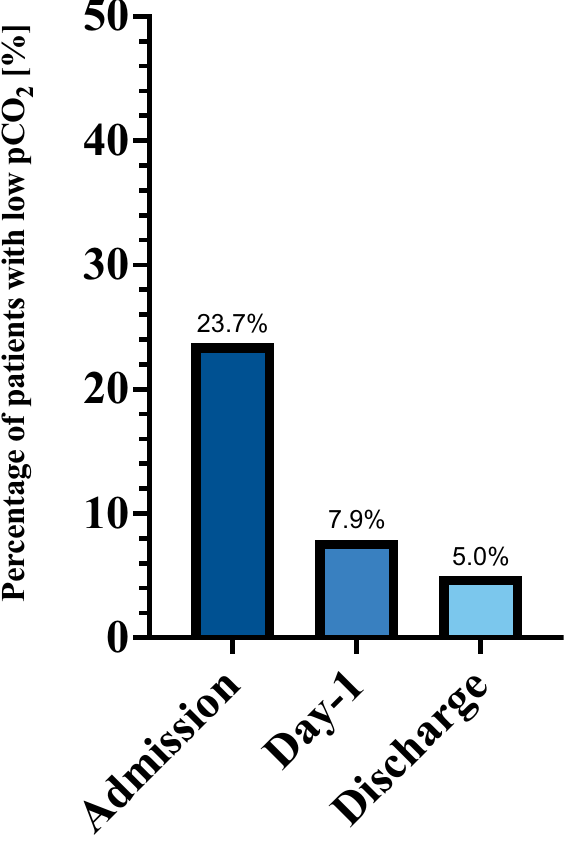
Figure 1. The prevalence of low pCO 2 (≤ 30 mmHg) in AHF patients during hospital